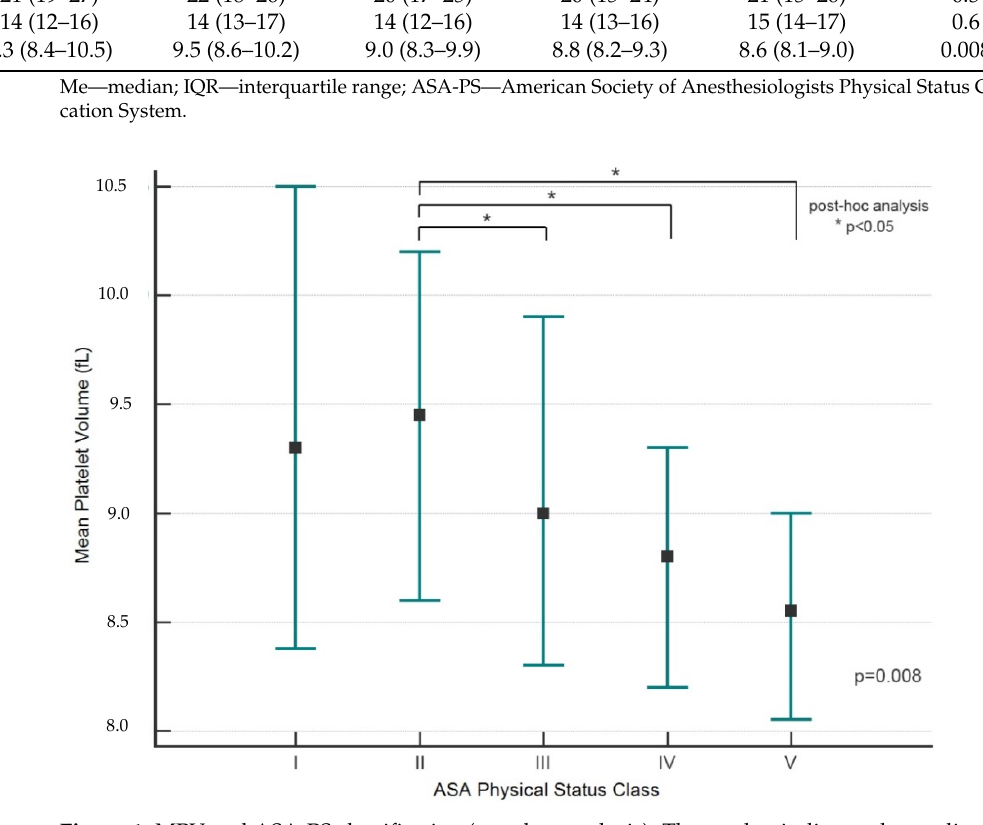
Figure 1. MPV and ASA-PS classification (post-hoc analysis). The marker indicates the median value (Me). The whiskers indicate an interquartile range (IQR, 25–75 pc); * p < 0.05 (post-hoc analysis). Patients whose individual risk was assessed as high according to ASA ‐ PS and SC had significantly lower MPV values, respectively: 9.0 vs. 9.4 fL ( p < 0.001) and 8.6 vs. 9.3 fL ( p = 0.003) (Table 5). Table 5. PLT and MPV values, and individual risk according to ASA ‐ PS and SC.